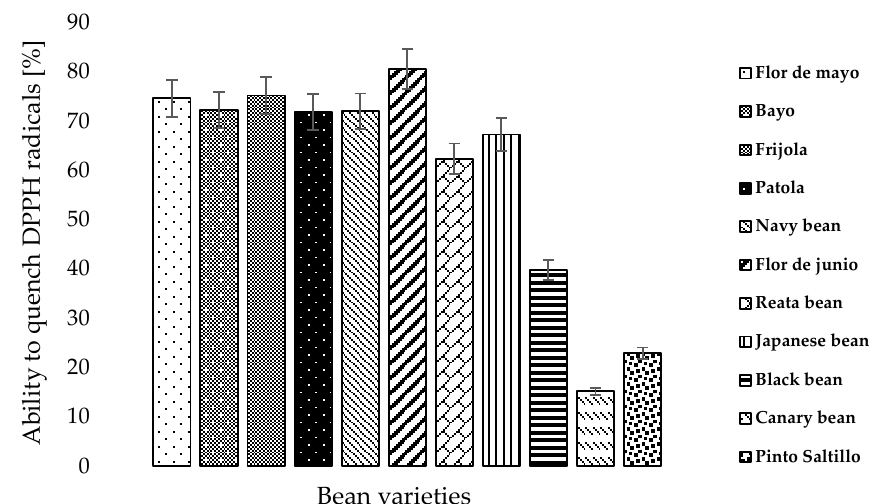
Figure 1. Antioxidant capacity (DPPH) of bean varieties grown in the state of Zacatecas, Mexico. Data are shown as the mean ± standard error ( n = 3). DPPH, 2-diphenyl-1 picryl hydrazyl.